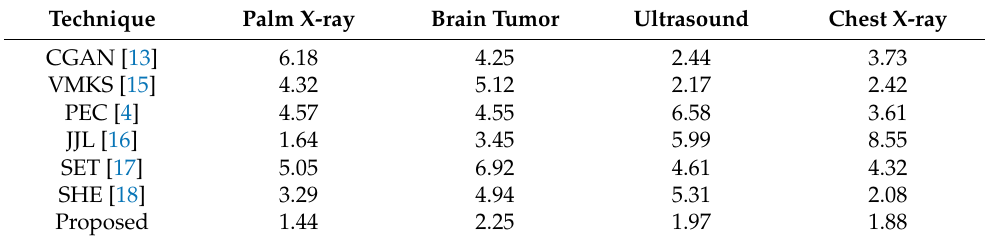
Table 2. Performance evaluation of color images in terms of PSNR between actual and encrypted images.